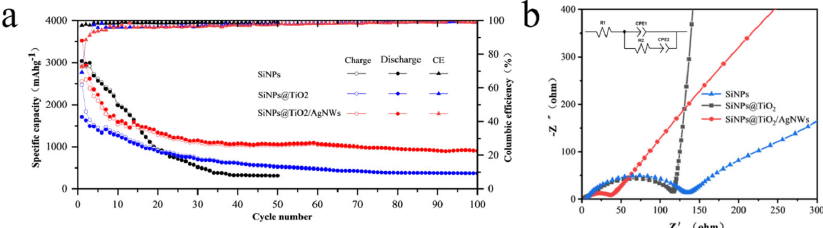
Figure 6. SiNPs, SiNPs@TiO 2 and SiNPs@TiO 2 /AgNWs ( a ) cyclic characteristic curves, and ( b ) EIS, the illustration in the upper left corner shows the equivalent